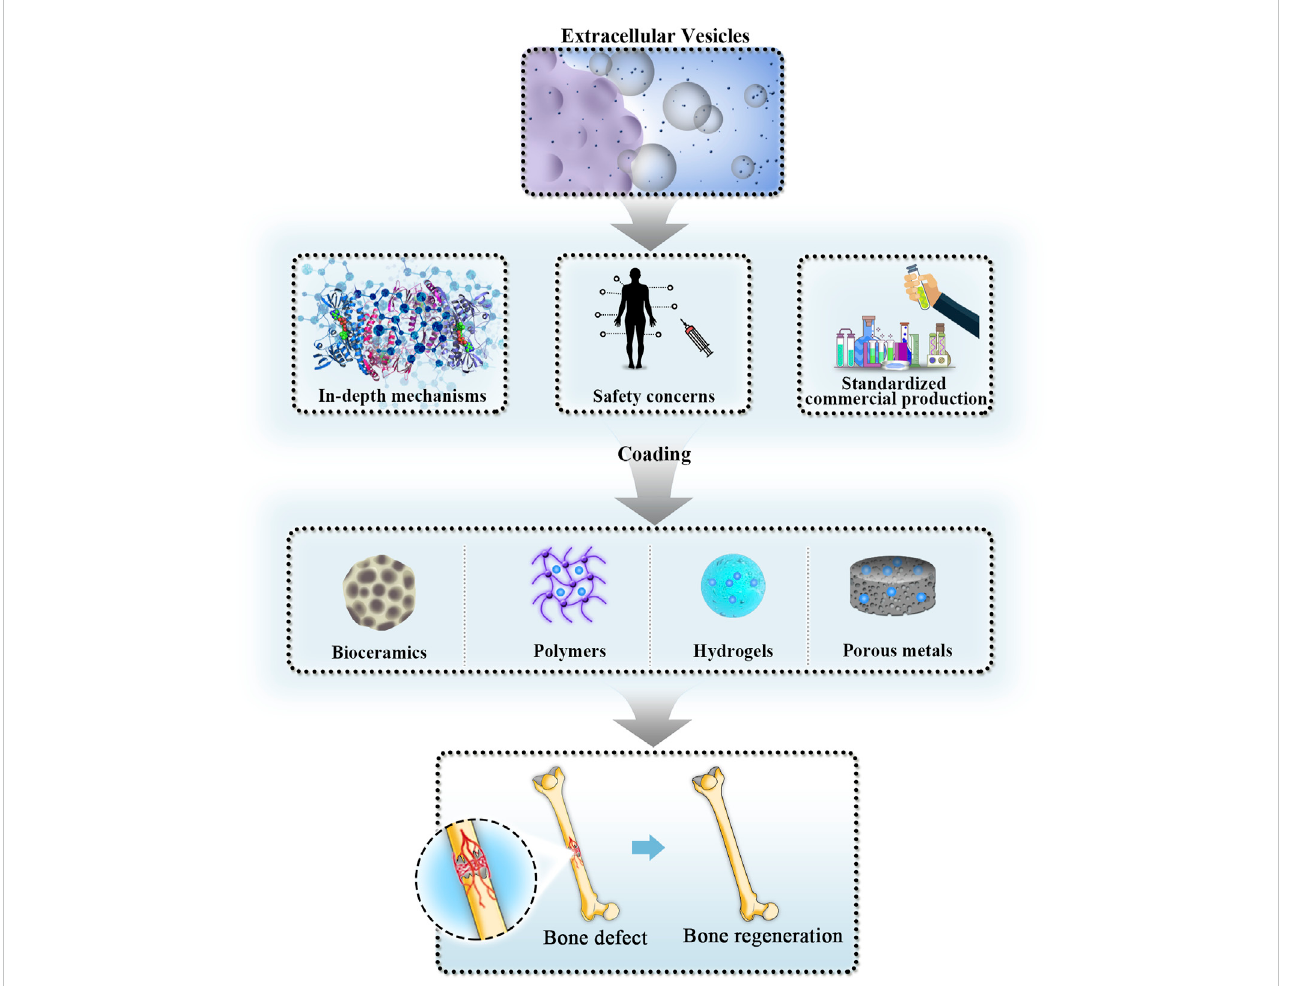
FIGURE 3 FutureperspectivesandchallengesofEVclinicalapplicationinBTE.EVshaveshownexcitingapplicationprospectsinrepairingcritical-sizebonedefects. In the near future, scholars will focus on studying in-depth mechanisms, solving safety concerns and promoting standardized commercial production of EVs applied in BTE. With further development of bioactive scaffold materials, cell-free regenerative medicine in BTE will soon be widely used. BTE: bone tissue engineering; EVs: extracellular